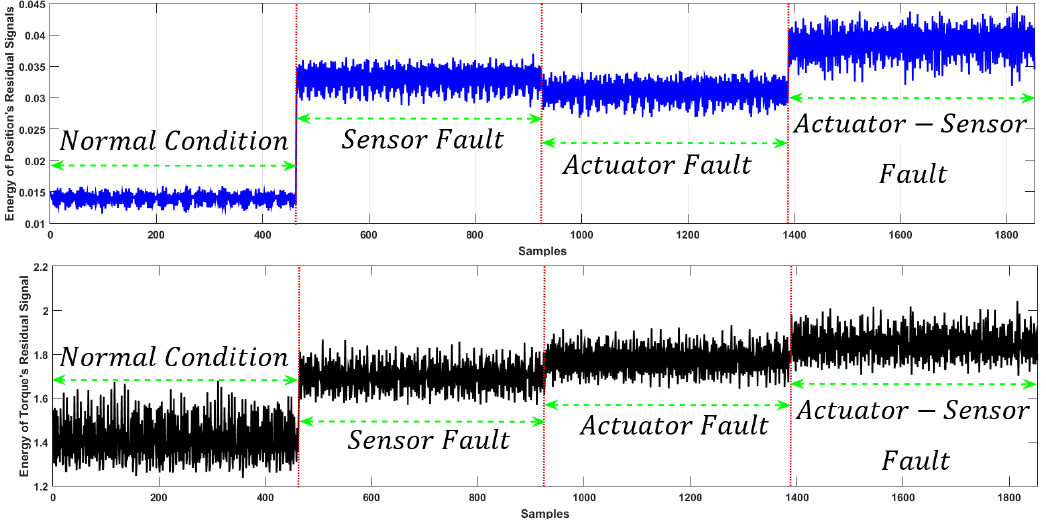
Figure 6. Energy of the torque and position residual signals of robot manipulator’s joints considering four different conditions for fault classification.